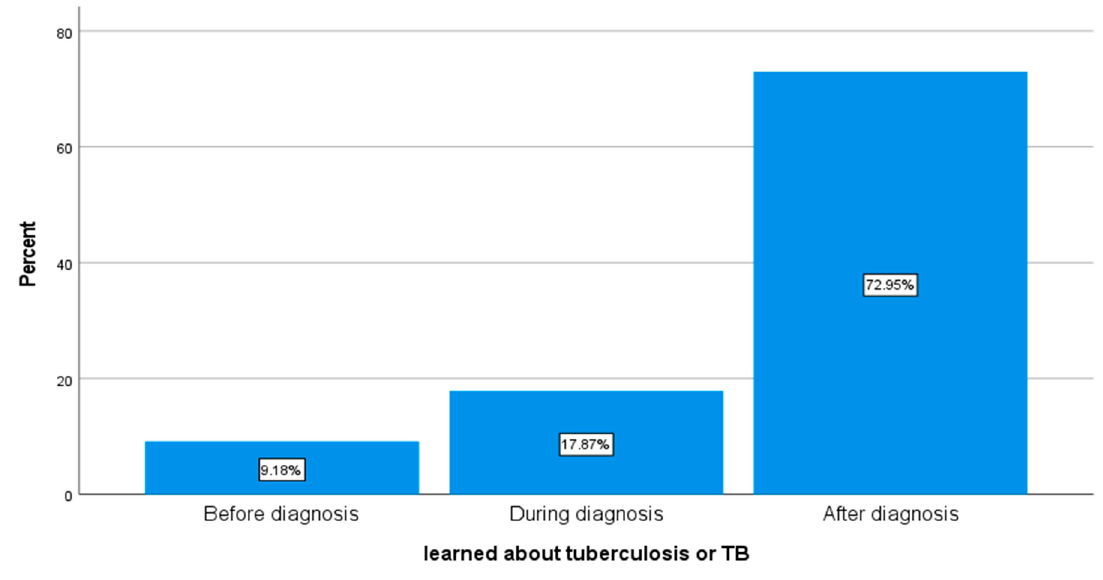
Figure 1. Respondents’ first time of learning about TB ( n = 207).